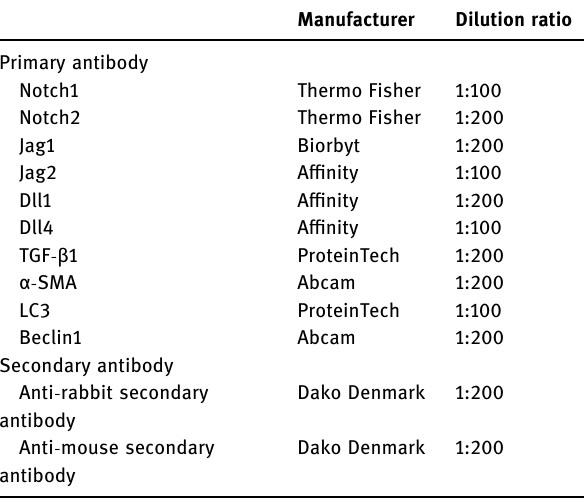
Table 1: Primary antibodies and their dilutions in this study